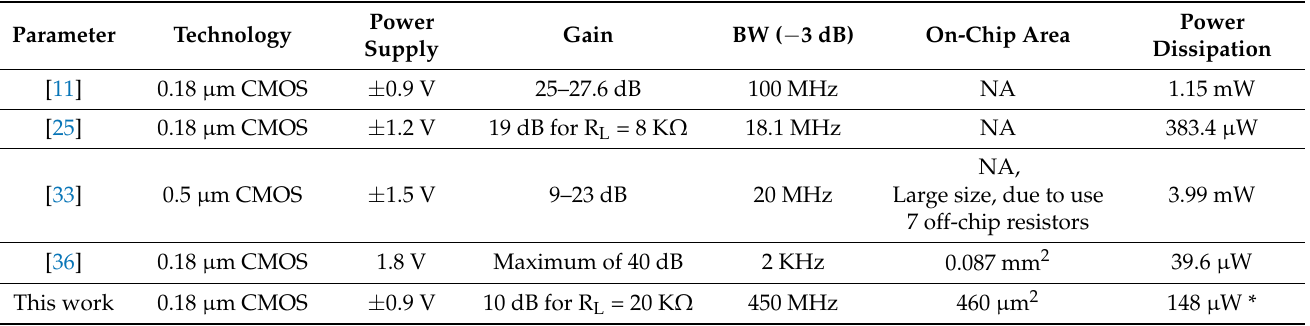
Table 3. Features of the designed CMIA compared to other works.